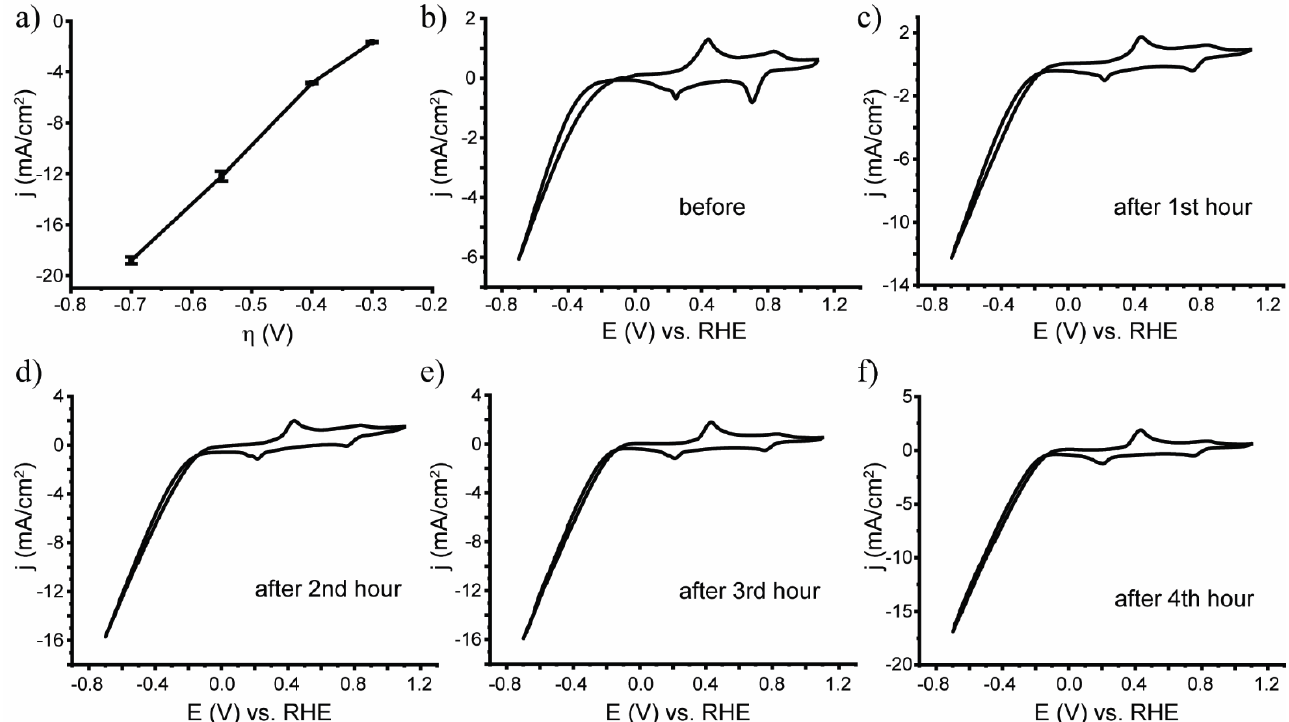
Figure 6. ( a ) Chronoamperometric data for PANI/AgPt at different overpotentials; ( b – f ) CV of PANI/AgPt samples recorded before and after each hour of chronoamperometry.